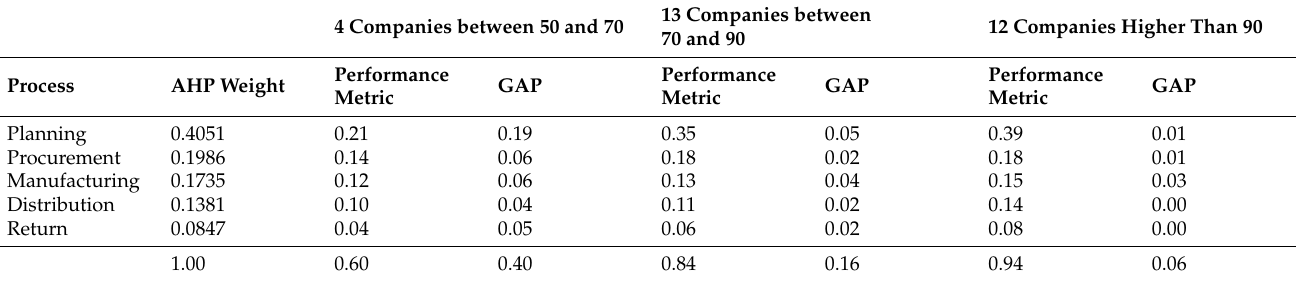
Table 11. Supply chain performance GAPs of groups of companies that answered the survey by index